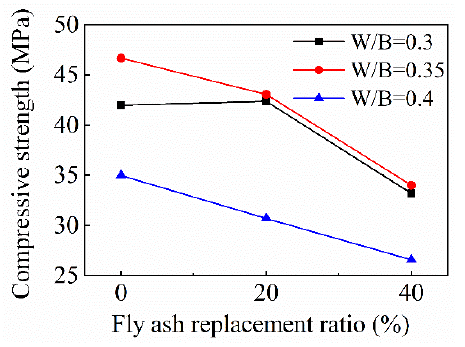
Figure 8. Variation of FRAC compressive strength with fly ash replacement ratio.